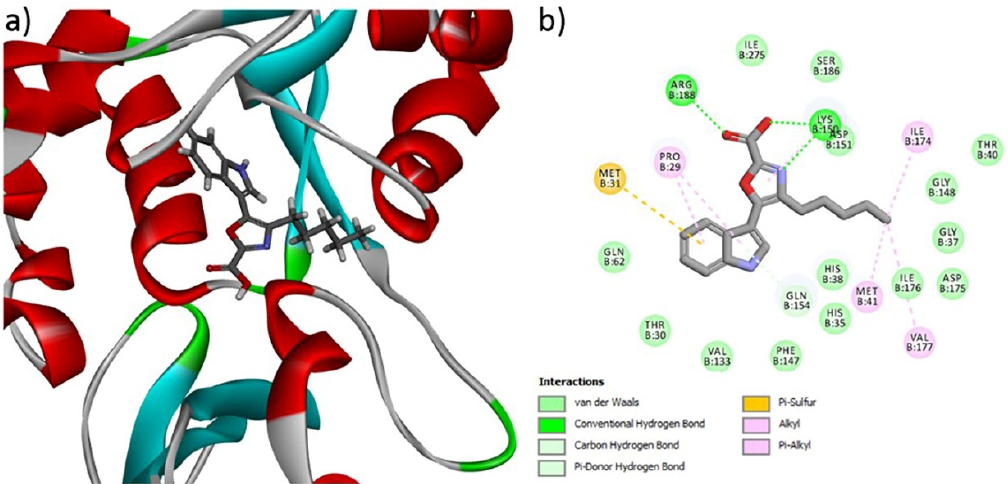
Figure 7. ( a ) 3D and ( b ) 2D interactions of Compound 1 at the active site of the pantothenate syn- thetase protein of MRSA.